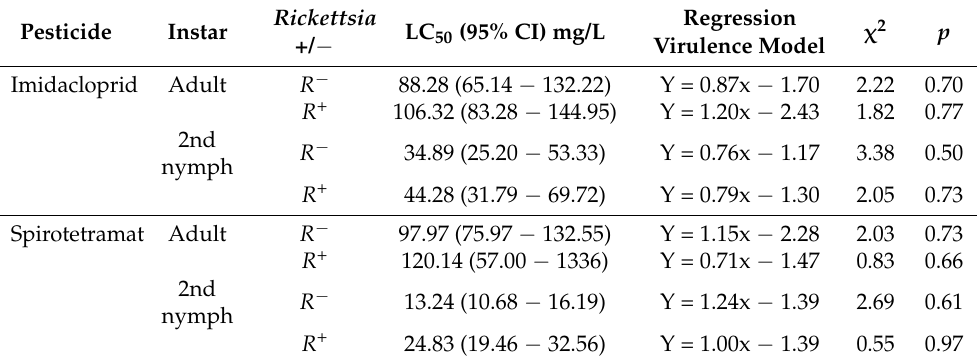
Figure 6. The effects of imidacloprid and spirotetramat on the mortality of second instar nymphs ( a , c ), adults ( b , d ) of Rickettsia positive and Rickettsia negative B . tabaci MEAM1 cryptic species. R +: Rickettsia positive population, R − : Rickettsia negative population. Control treatment (CK) was ddH 2 O. Table 2. Toxicity of imidacloprid and spirotetramat against different developmental stages of Rickettsia positive and Rickettsia negative B . tabaci .